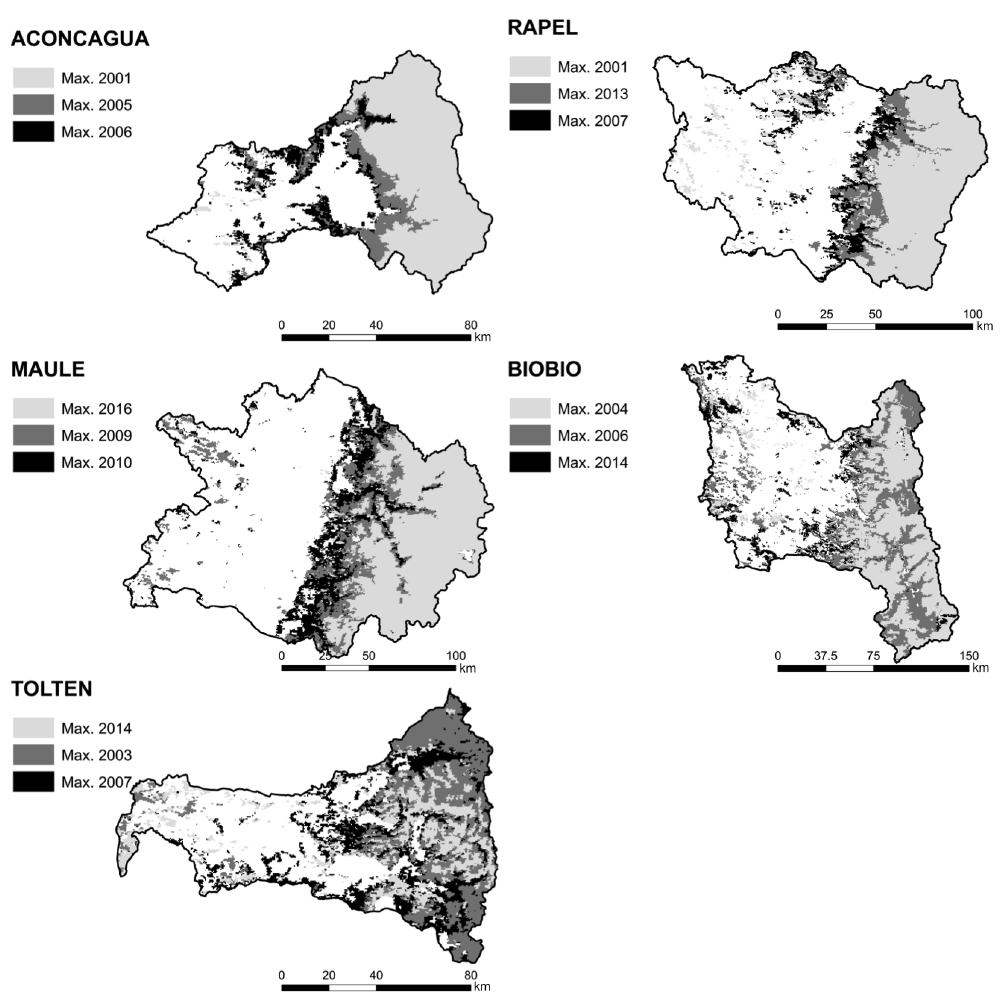
Figure 7. Spatial representation of SCA for the period 2000–2016 in Aconcagua, Rapel, Maule, Biobío and Toltén watersheds. Black indicates the year with maximum SCA, dark grey the year with average SCA and grey the year with minimum